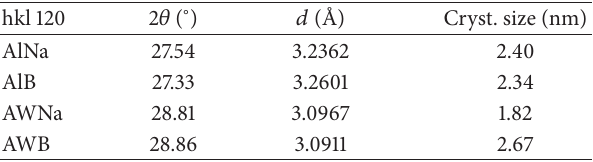
Table 1: Diffraction angle, reticular space, and crystallite size of